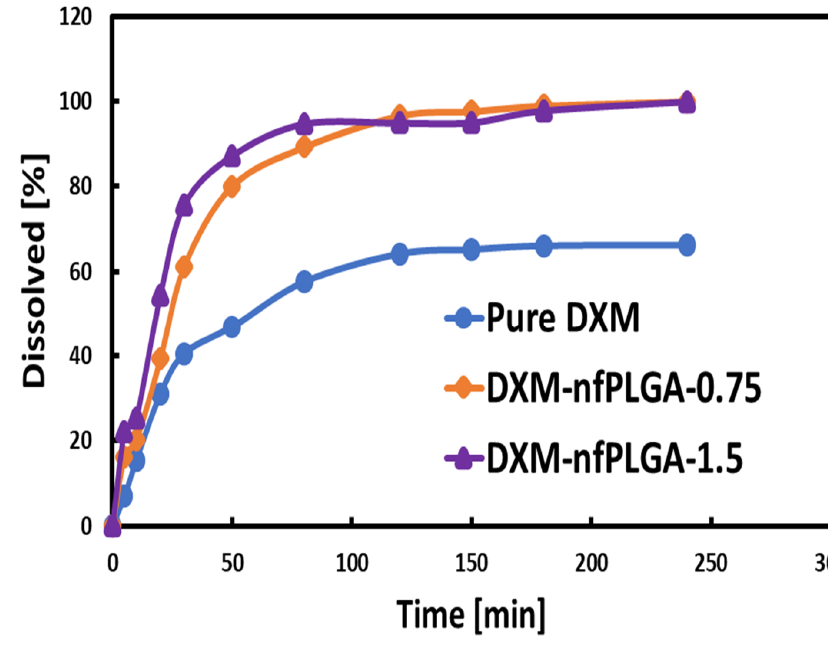
Figure 9. Dissolution profile for DXM–nfPLGA composites.